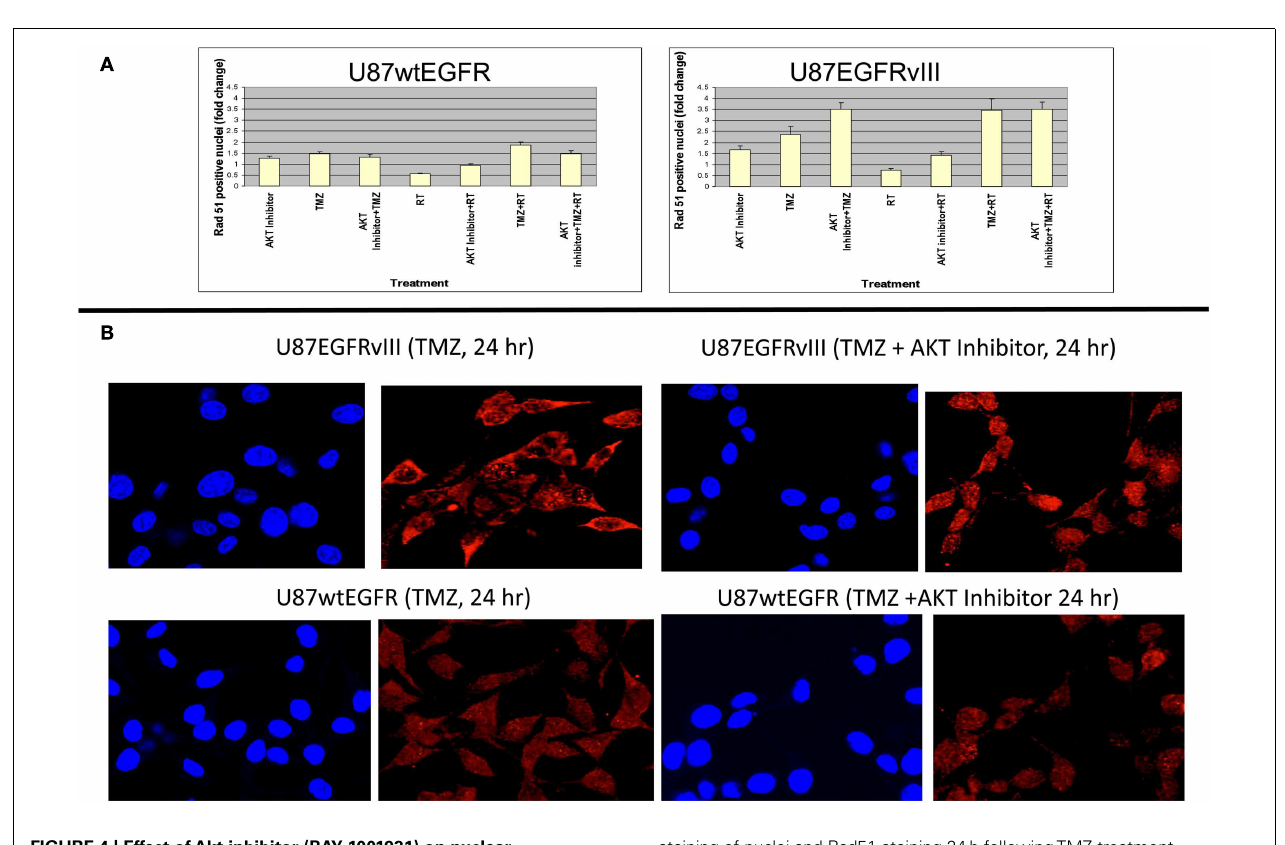
staining of nuclei and Rad51 staining 24h followingTMZ treatment (20 µ M) with and without Akt inhibitor [BAY1001931 (500nM) of